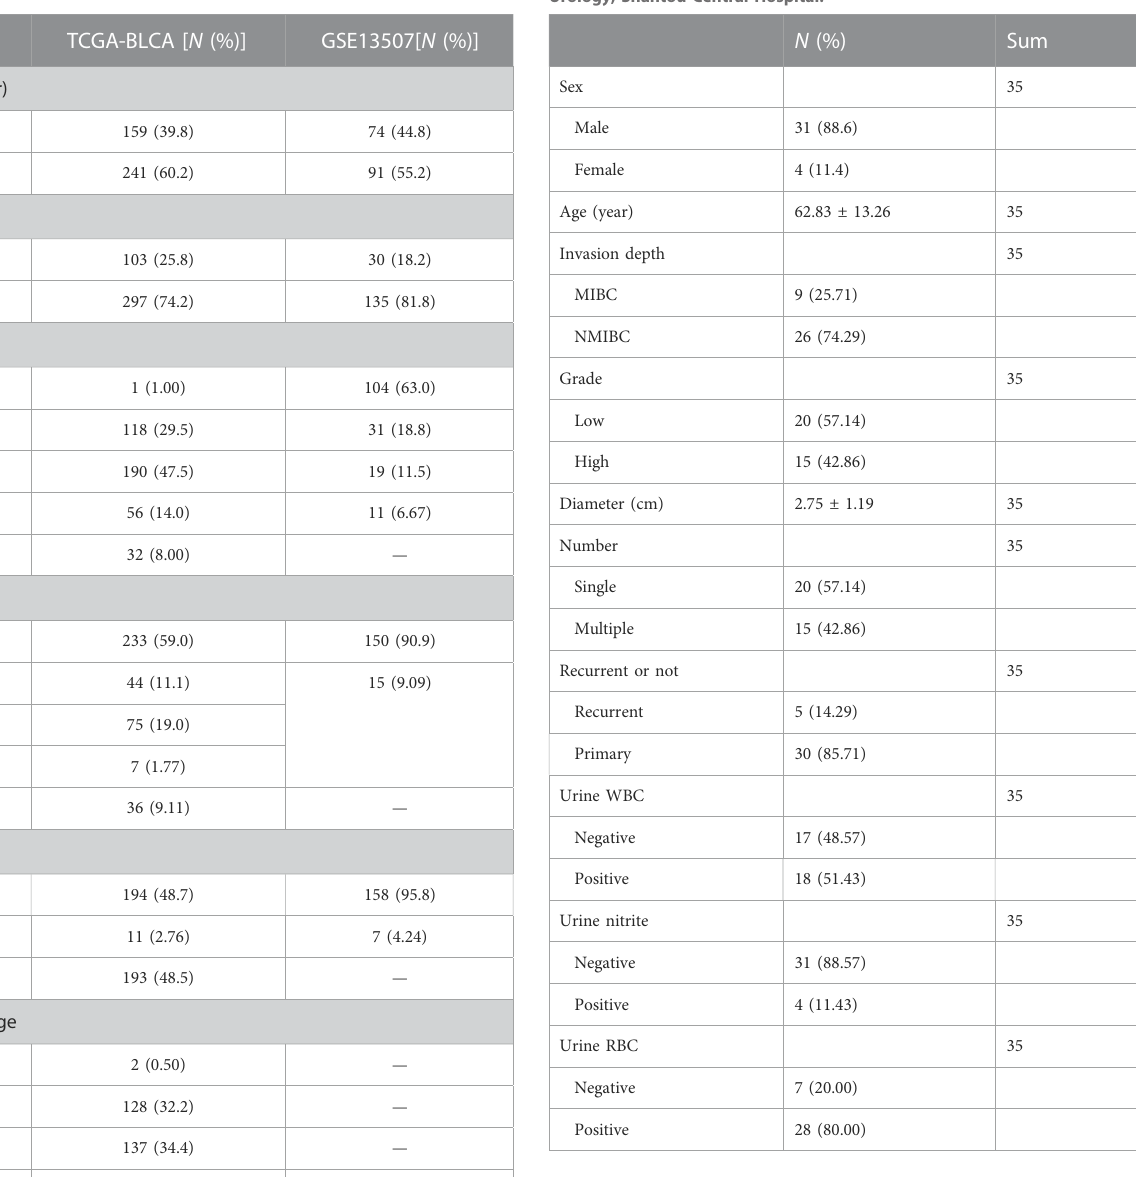
TABLE 2 Baseline data sheet of TCGA-BLCA ( N = 400 cases) and GSE13507 ( N = 165 cases).